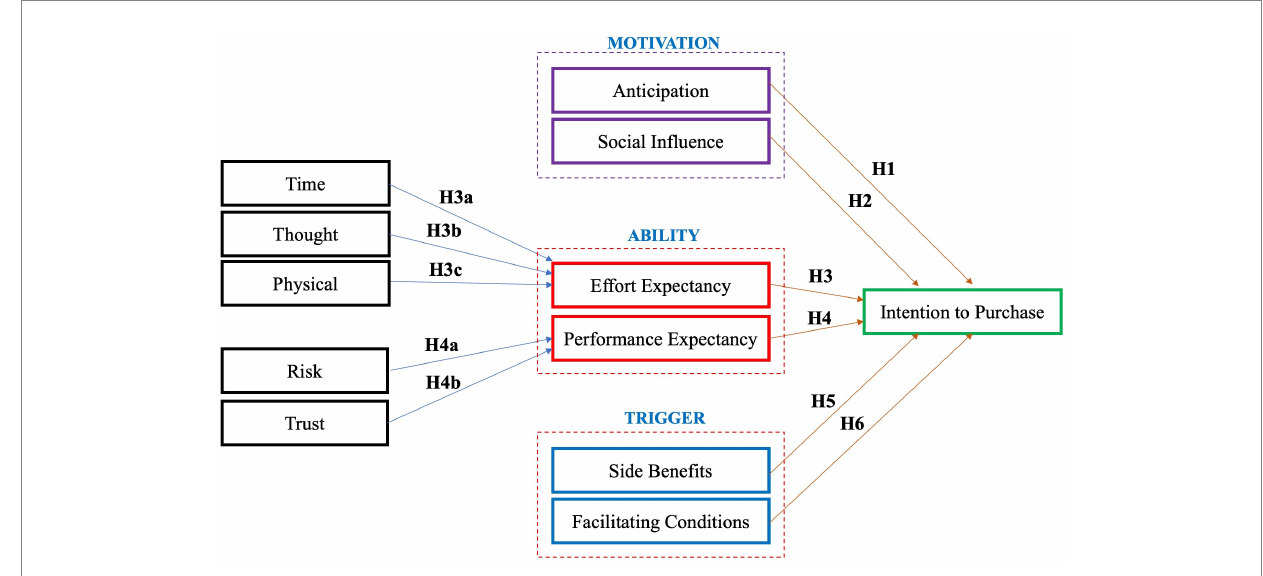
FIGURE 1 The conceptual